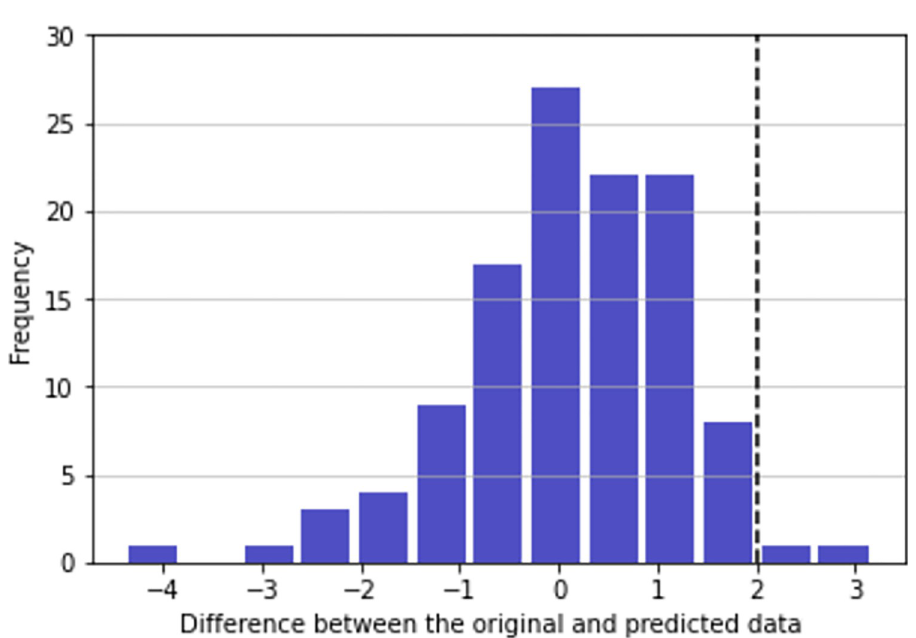
Fig 3. Difference between the value and the prediction. The dotted vertical line indicates a threshold from potential learning malpractice. Null attempts and the number of attempts are considered.